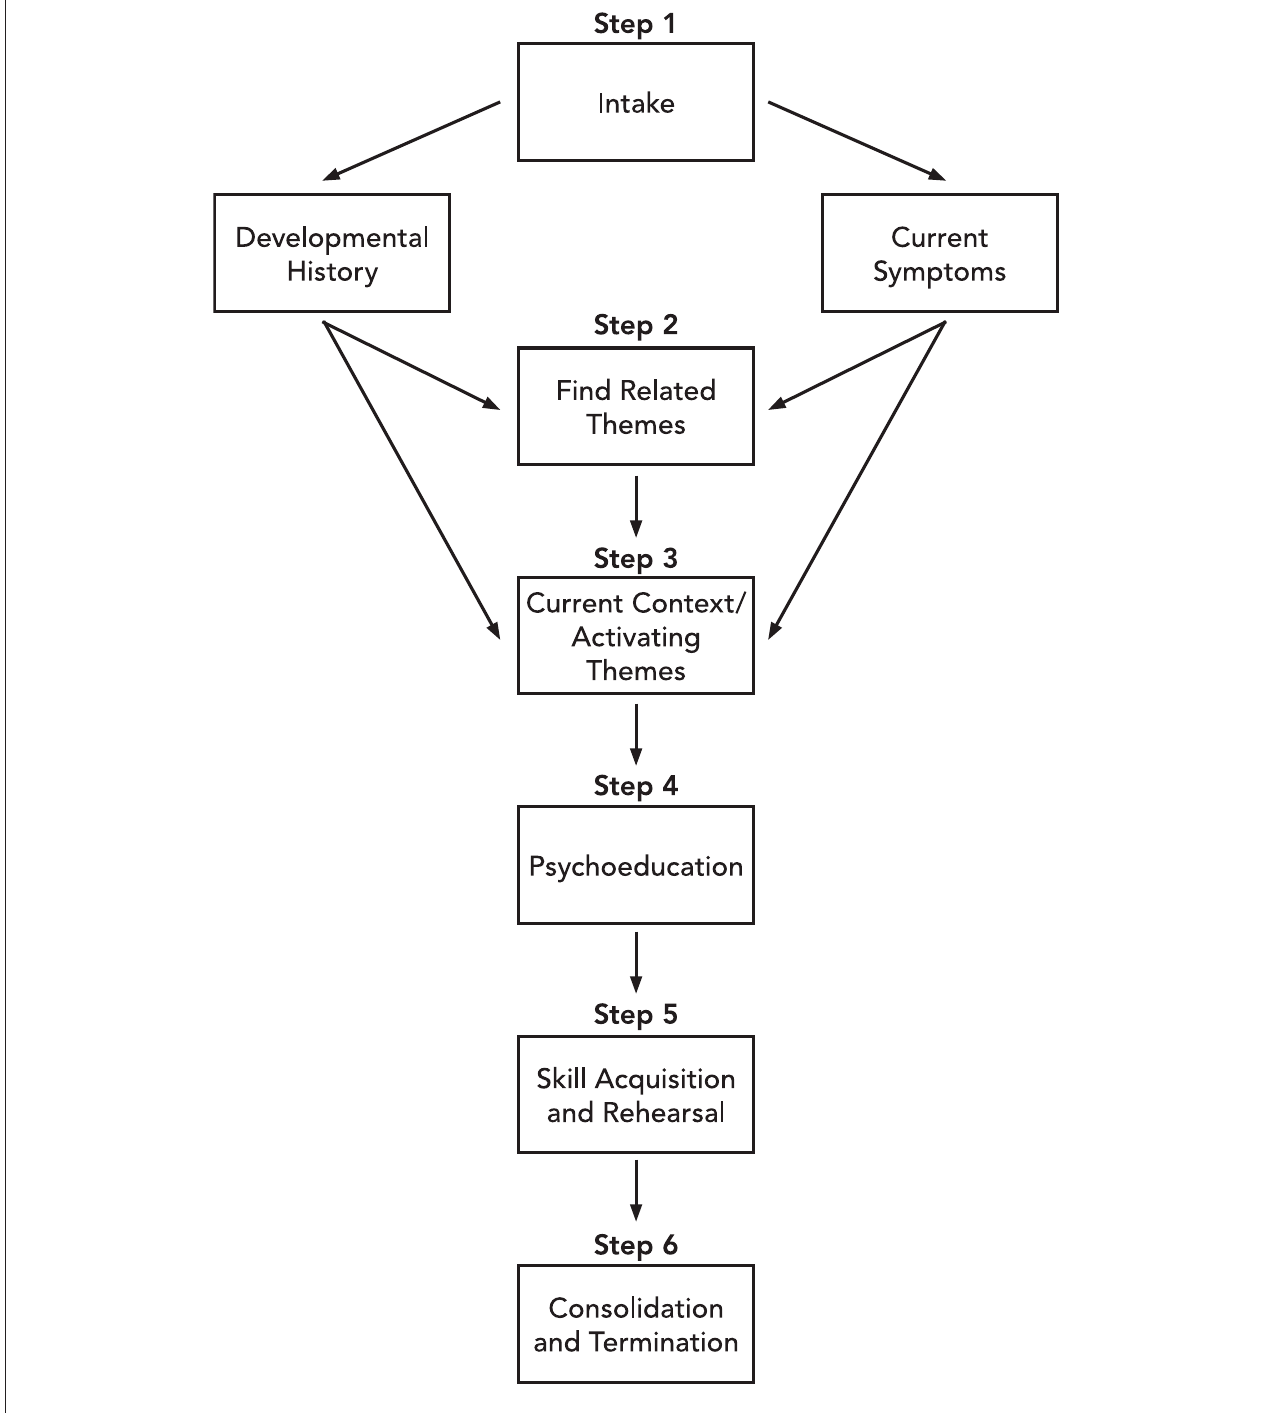
FIGURE 1 | Integrated psychodynamic